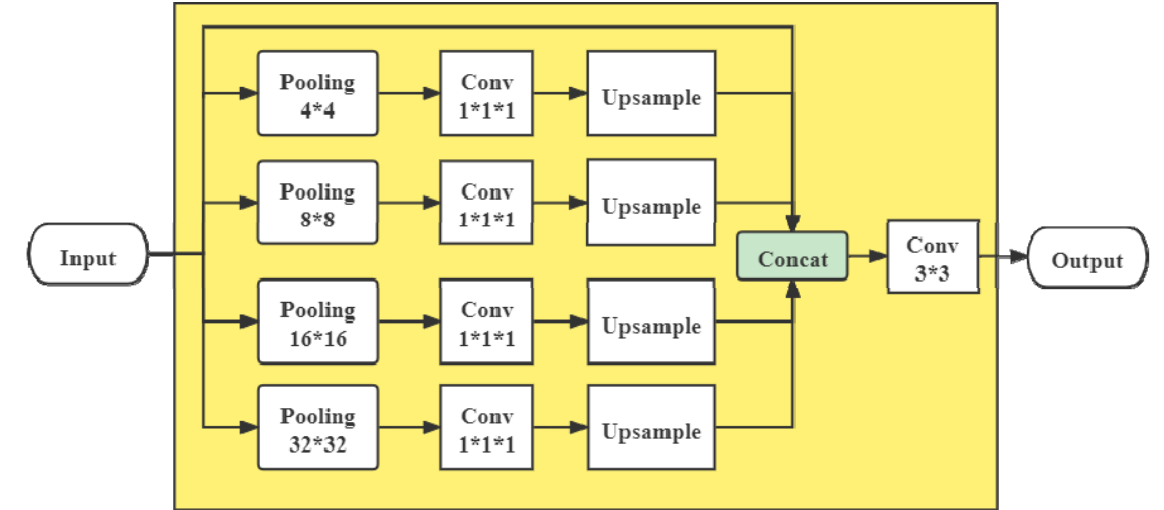
Figure 7. Pyramid pooling block.